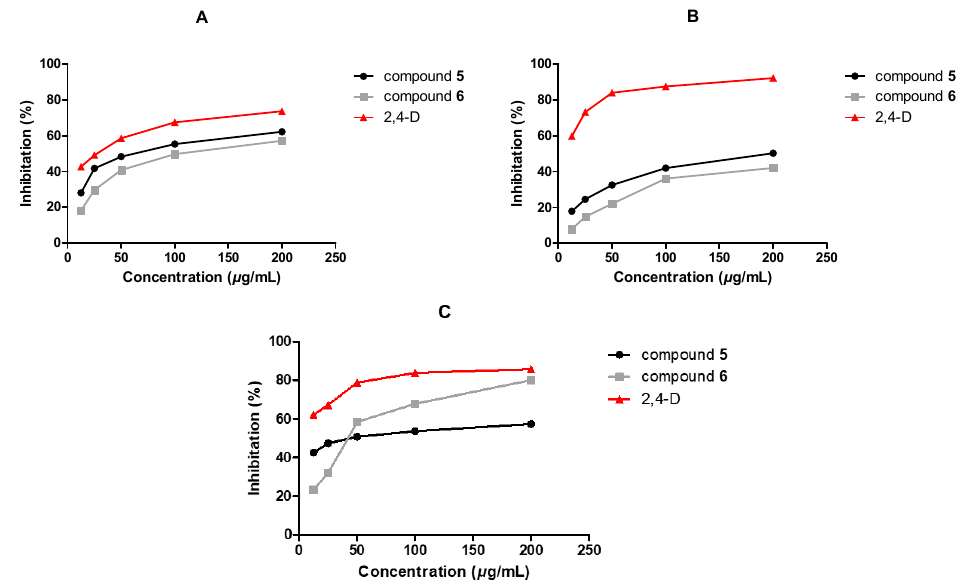
Figure 5. Herbicidal activities of compounds 5 , 6 and 2,4-D (2,4-dichlorophenoxy acetic acid, used as a positive control) on the growth of seedlings of E . crusgalli and A . retroflexus at concentrations of 12.5, 25, 50, 100, and 200 μ g/mL, respectively. ( A ) shoot of E . crusgalli , ( B ) root of E . crusgalli , ( C ) radicle and germ of A . retroflexus . Values are presented as a percentage of the mean compared to the control ( p < 0.05).